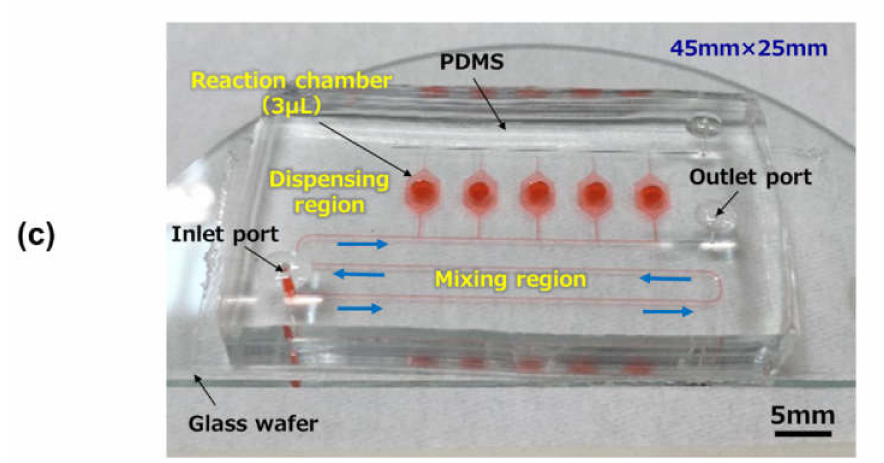
Figure 1. ( a ) Schematic diagram of a parallelized microfluidic device integrated with a chaotic mixer and phaseguide-assisted sample dispensers for multiplex genetic diagnosis. ( b ) Detailed design of the reaction microchamber integrated with three types of phaseguide structures with di ff erent inclined angles to be used as passive stop valves to dispense the same volume of sample solution into each microchamber. ( c ) Photograph of the fabricated polydimethylsiloxane (PDMS) microfluidic device filled with red